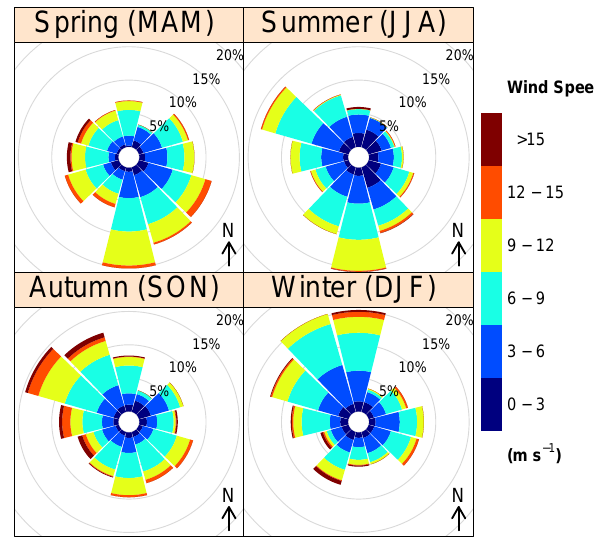
Fig. 2. Wind rose plots showing wind speed as a function of di- rection during 2010 at the KCMP tall tower. MAM: March, April, May; JJA: June, July, August; SON: September, October, Novem- ber; DJF: December, January,